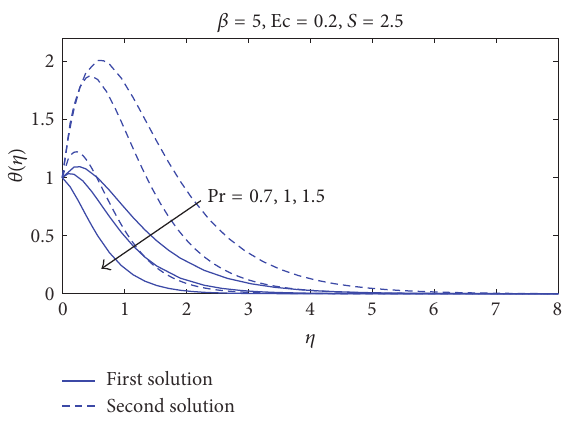
Figure 11: Temperature profiles for different values of Pr.